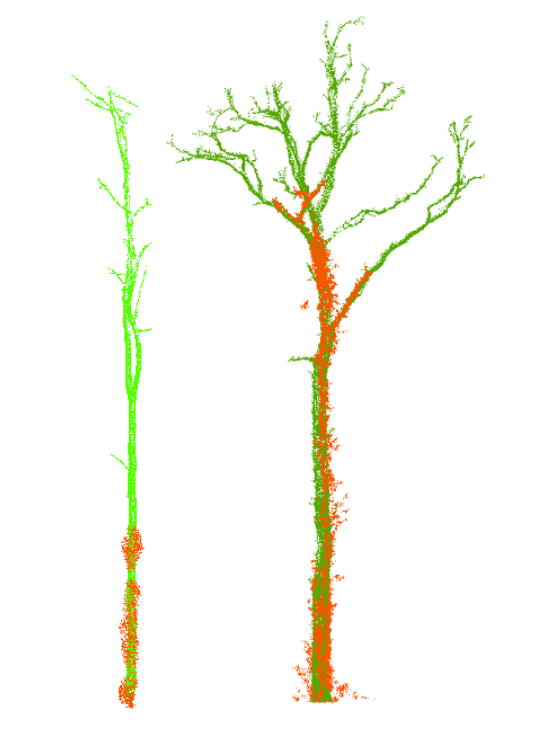
Figure 3: TLS-trees (green) and reconstructed trees (red). Left shows a partly reconstructed smaller tree. Right shows a tree with a fully reconstructed stem and parts of the crown.